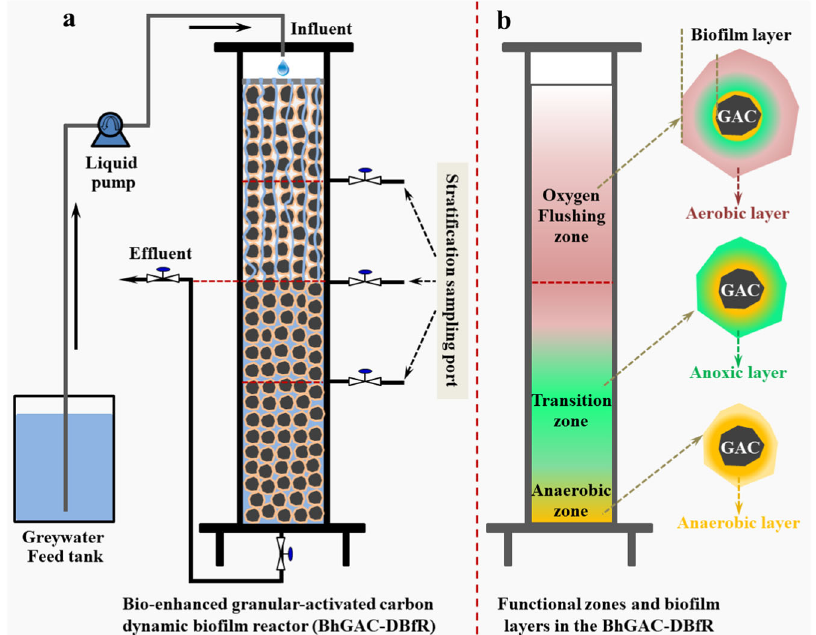
Fig. 7 Experimental setup. Schematic of a the bio-enhanced granular-activated carbon dynamic bio fi lm reactor (BhGAC-DBfR) and b the functional zones and bio fi lm layers in the BhGAC-DBfR at the noted position of strati fi cation (saturated/unsaturated ratio = 1:1.1) during graywater